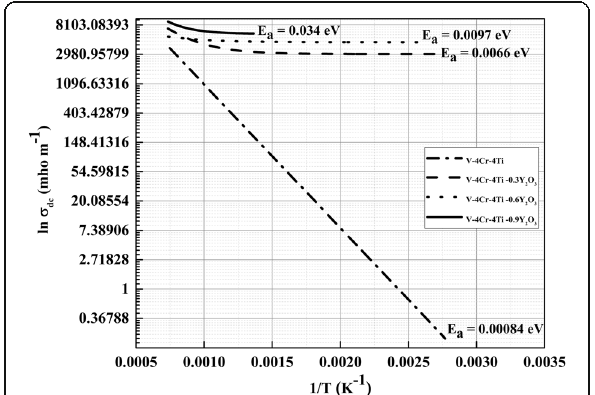
Fig. 4 Activation energy ( E a ) profiles of V – 4Cr – 4Ti and yttria-dispersed V – 4Cr – 4Ti powders depicting the suppression of sintering current (DC conductivity) as a function of varying yttria content in starting powders, during FAST